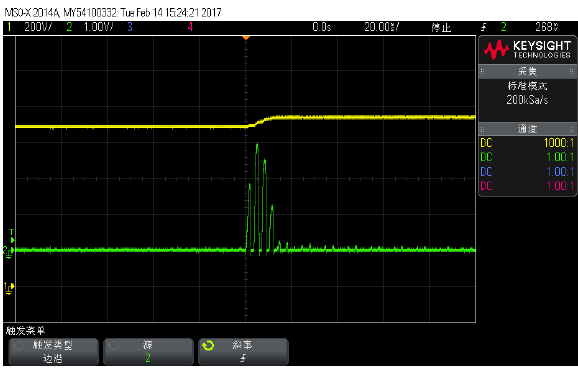
Fig. 9. The capacitor charging waveform of removing the soft-start resistor. X-axis: 2s/div Y-axis: 200V/div,